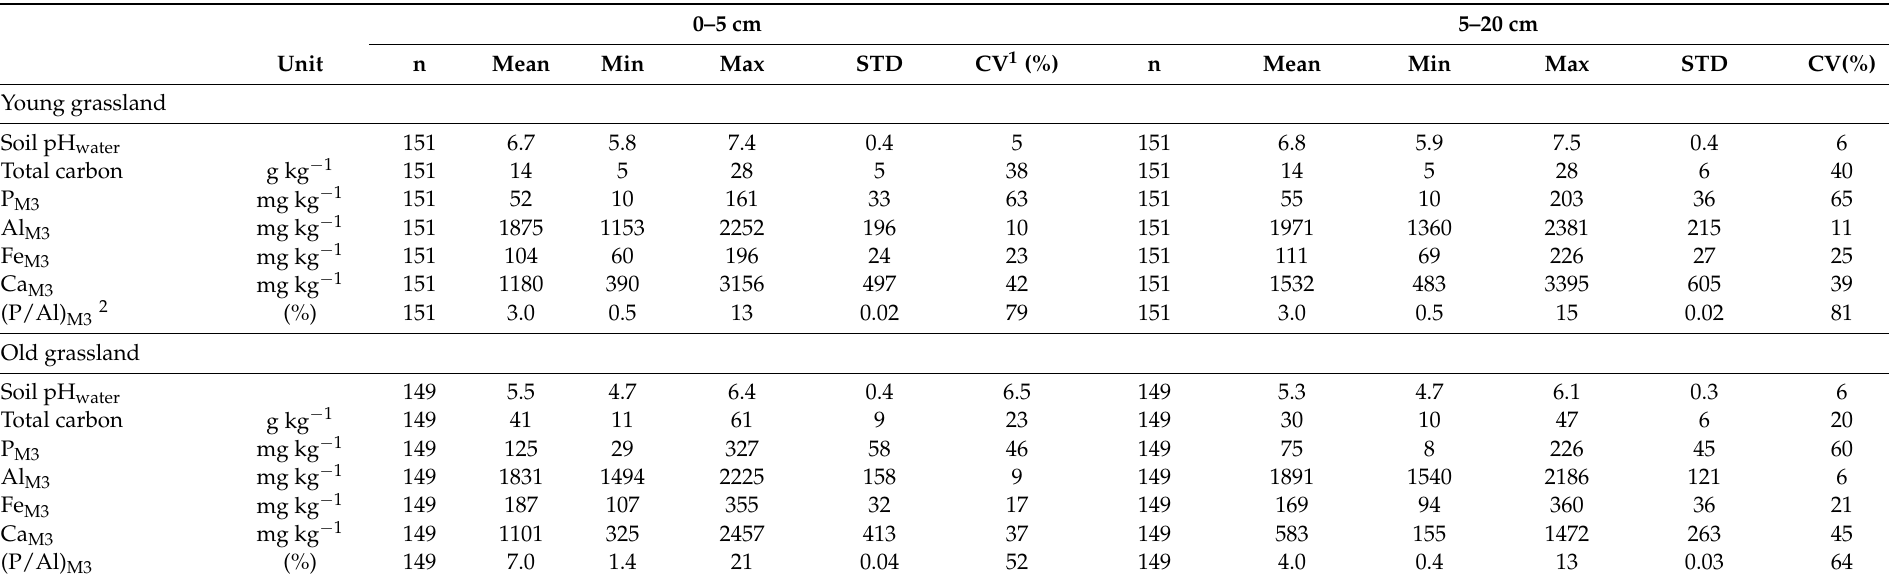
Table 1. Descriptive statistics of the soil chemical properties for two soil layers (0–5 cm and 5–20 cm) in the young and old grassland